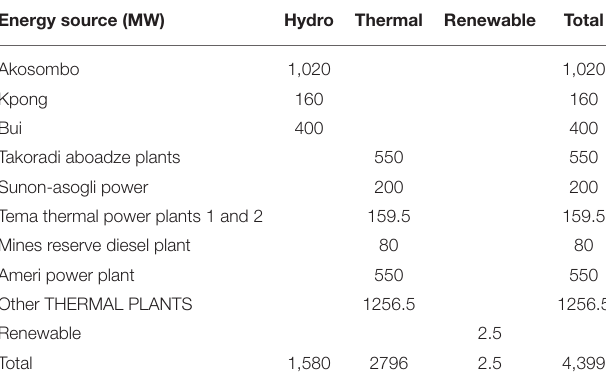
TABLE 1 | Types of energy sources in